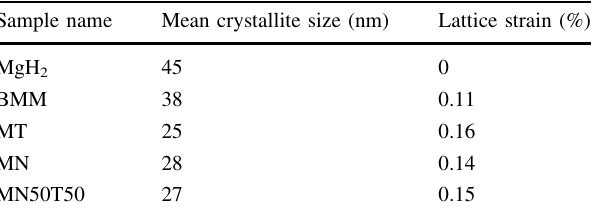
Fig. 1 XRD patterns of the different samples Table 1 Mean crystallite size and lattice strain of the ball-milled